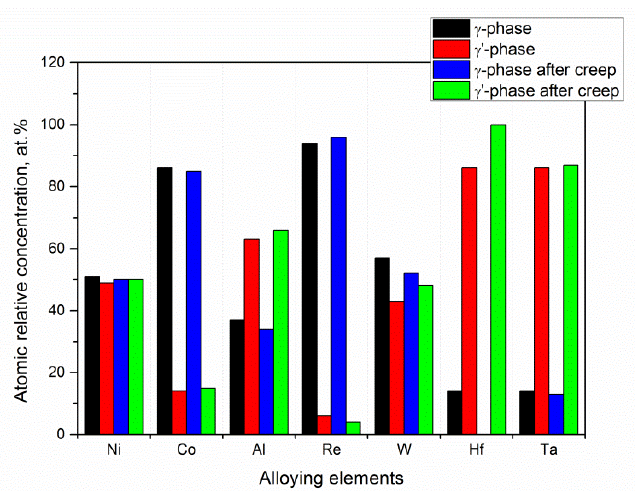
Figure 16. Elemental distribution between the γ and γ′ phases before and after the creep test.